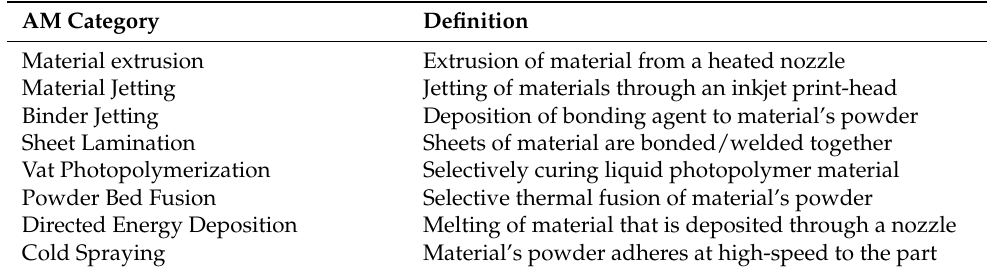
Table 1. Additive manufacturing categories